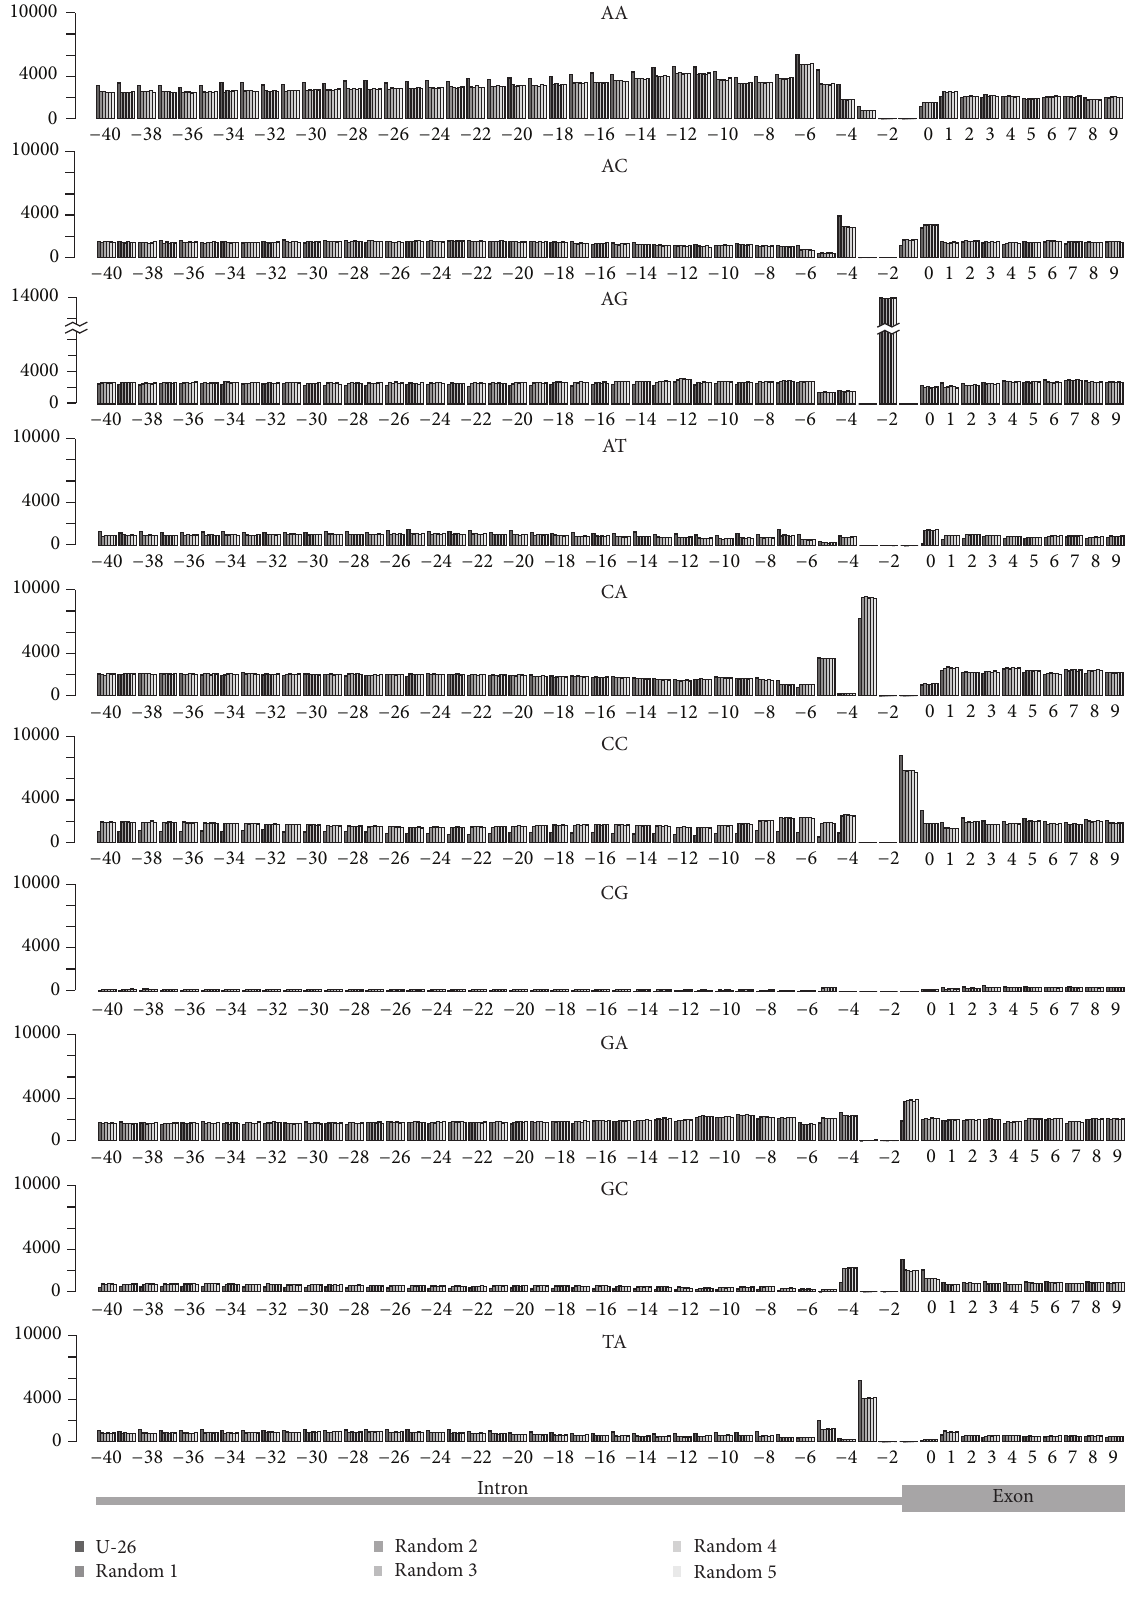
Figure 4: Dinucleotide counts at intron-exon boundary. The dinucleotide counts for the region − 40 to +10 nucleotides from the upstream boundary between intron and exon as indicated at the bottom of the figure. Solid black bar indicates the counts for exons containing the U − 26 signal. Grey bars represent 5 random samples of similar size for